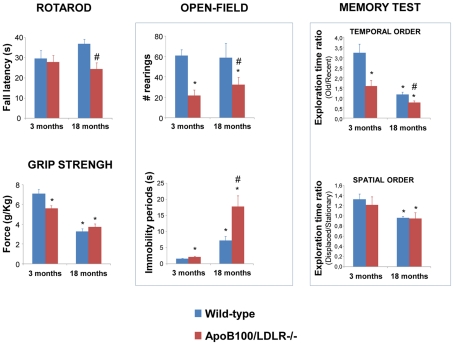
Behavioural phenotyping.Effects of genotype (blue bar  =  wild-type, red bar  =  transgenic) and age on fall latency (in seconds to fall from the accelerating rotarod); grip strength (expressed as g/kg of weight); vertical activity (number of rearings) and period of immobility (in seconds, open field test); and temporal memory (as a ratio) and spatial memory (as a ratio). Data are expressed as means±SEM. *Significantly different (P<0.05) compared to 3-month-old wild-type mice; #Significantly different (P<0.05) between wild type and transgenic mice.